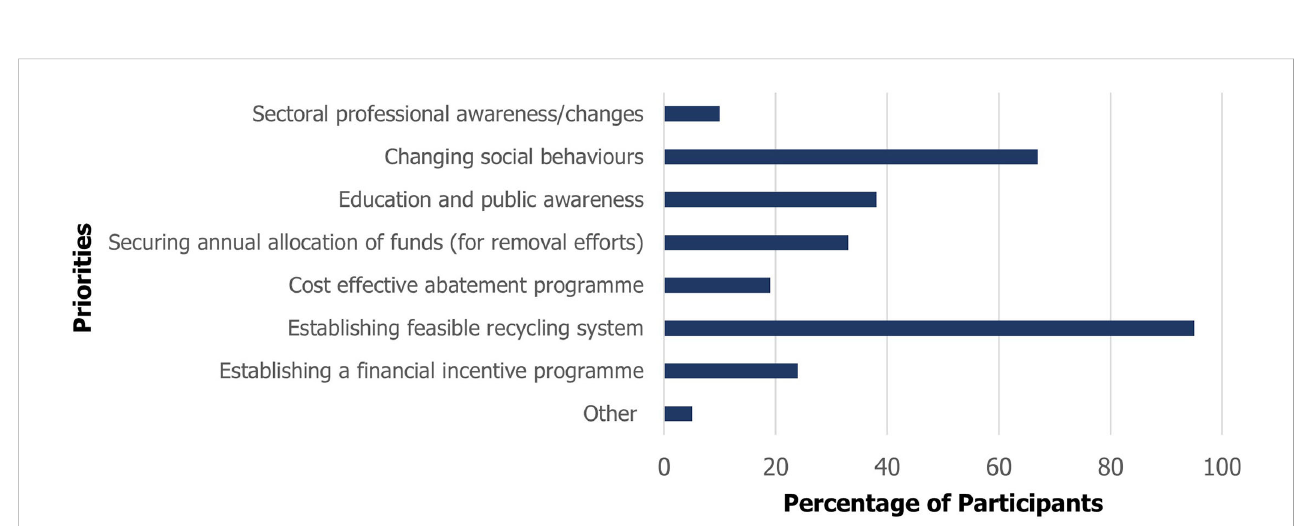
FIGURE 9 Participants perspectives on what national priorities should be for enabling on-the-ground actions for better coastal and marine litter prevention and